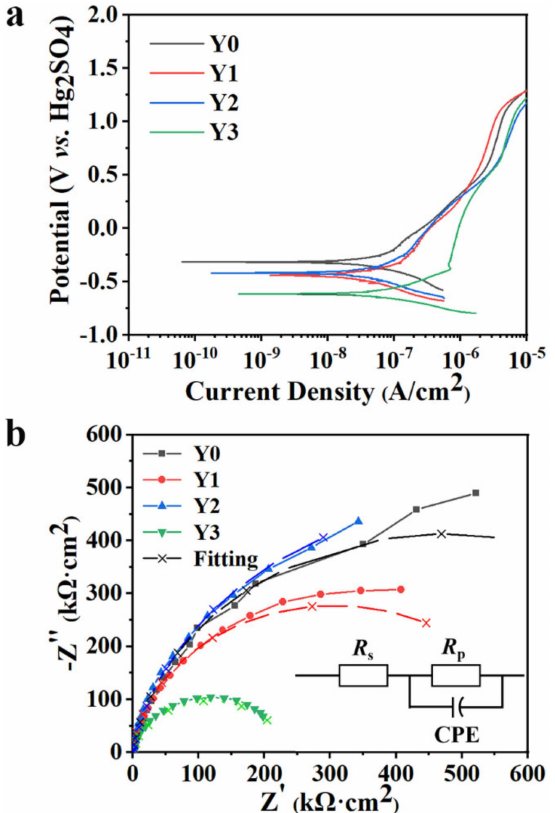
Figure 7. ( a ) Polarization curves and ( b ) Nyquist plots of the Y0, Y1, Y2, and Y3 samples with the equivalent circuit in the